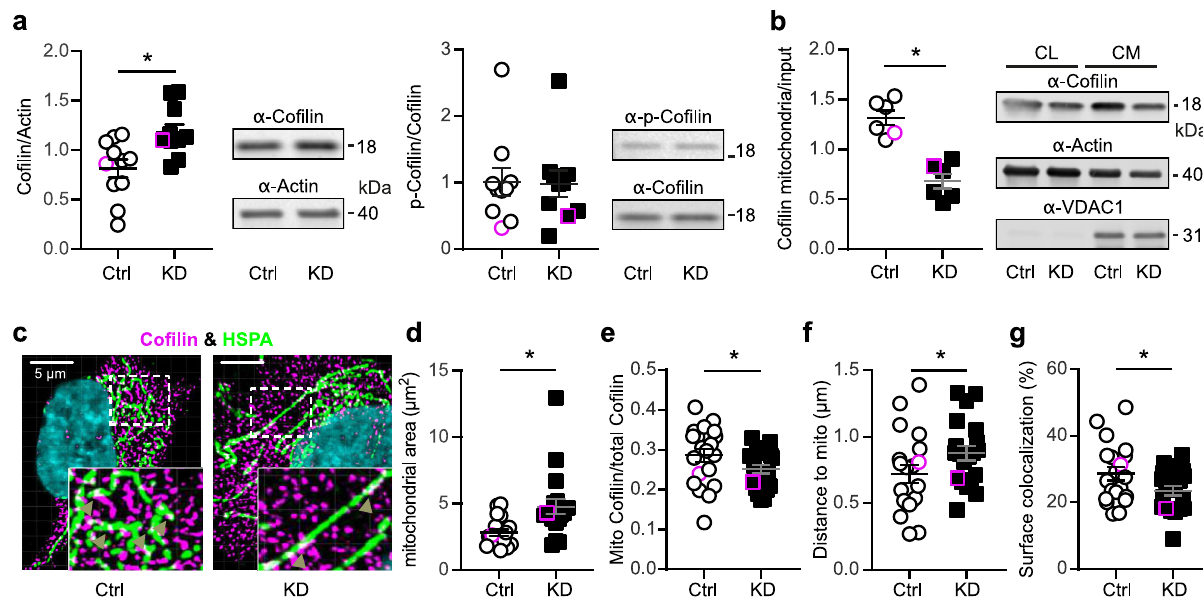
Fig. 7 Reduced presence of Co fi lin-1 at mitochondria. a Immunoblot of whole cell lysates and quanti fi cation of Co fi lin-1 and p-Co fi lin-1 (S3) protein levels. Actin served as loading control. b Analysis of Co fi lin-1 abundance at the mitochondria after fractionation of crude mitochondria (CM) normalized to Co fi lin- 1 levels in whole cell lysates (CL). c Immunostaining of Ctrl and GDAP1 KD cells for Co fi lin-1 and HSPA9 as mitochondrial protein. Nuclei were counterstained with DAPI. Imaris analysis con fi rmed ( d ) the increased mitochondrial area in KD cells and ( e ) a reduction of mitochondrially-located Co fi lin-1 (white, arrowheads) concomitant with ( f ) an increased distance between mitochondria and co fi lin-1. Conversion of the structures into surfaces using contact XTension demonstrated ( g ) that the proportion of the mitochondrial surface area in contact with Co fi lin-1 was signi fi cantly reduced. d , f Data are from a total of n = 20 cells per cell line from three independent experiments. Data points corresponding to the example are highlighted. Statistical variation is shown as scatter plots with the indication of mean ± SEM and signi fi cance calculated using the non-parametric Mann – Whitney test, * p <